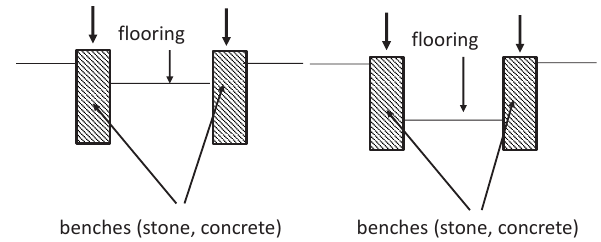
Figure 1: Typical foundation of the antique building (without or with basement).